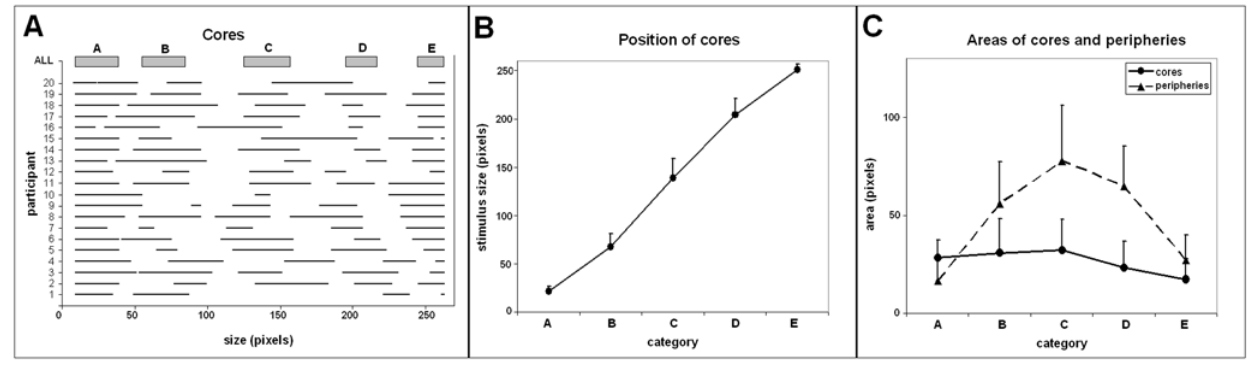
Figure 3. Positions and areas of cores and peripheries. Cores and peripheries are computed separately for each participant. a) Cores. Horizontal : stimulus size (diameter in pixels). Vertical : participants. Note : for participants 1 & 10, some cores are missing. Thick horizontal bars : ‘average core’ determined from the average position of the individual interval bounds. b) Position of the centers of the cores (average of the position of the individual cores). Vertical bars : standard deviation. Vertical : stimulus sizes (diameter in pixels). Horizontal : categories. c) Areas of the cores and peripheries (average of the individual areas). Common peripheries are counted twice, one for each neighbor category.